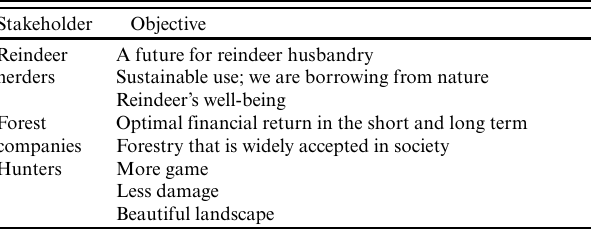
Table 4. Examples of fundamental